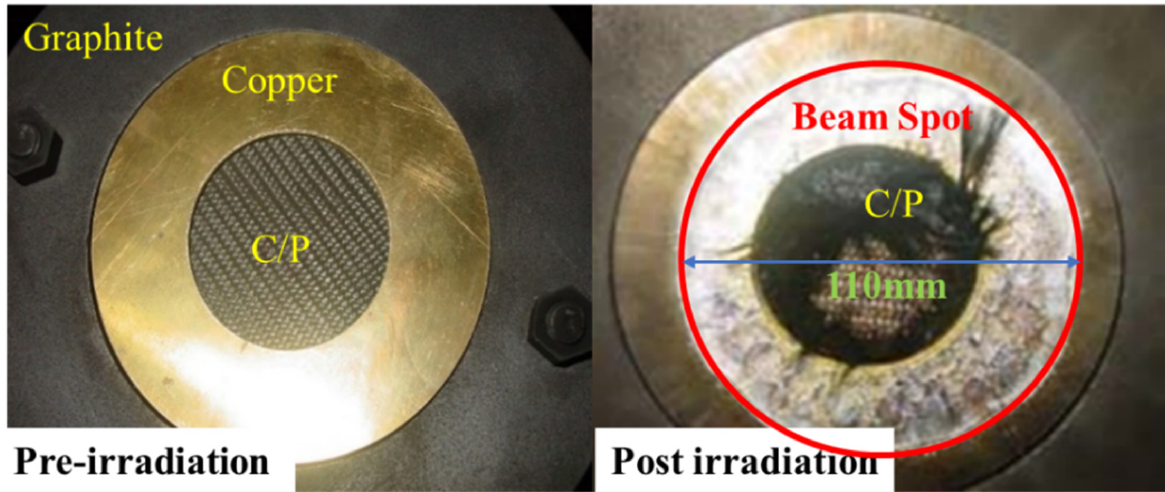
Figure 3. Experimental photos before and after X-ray irradiation.